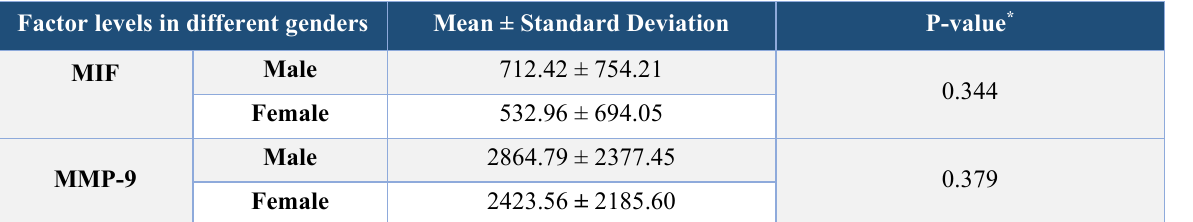
Table 2. Mean of factor levels in different genders of the study Factor levels in different